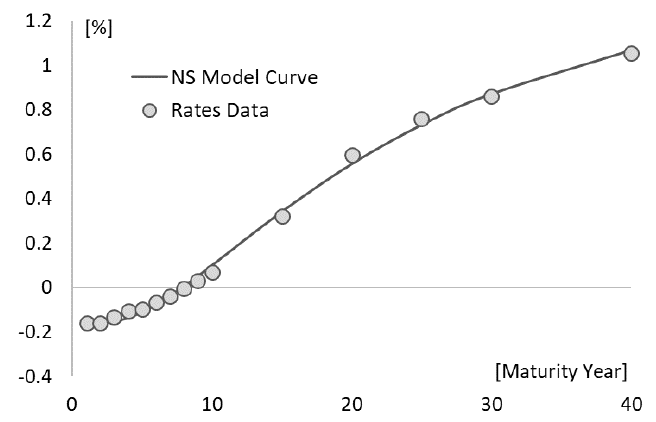
Figure 3. Japanese government bond (JGB) yield curve data and the Nelson–Siegel model curve.